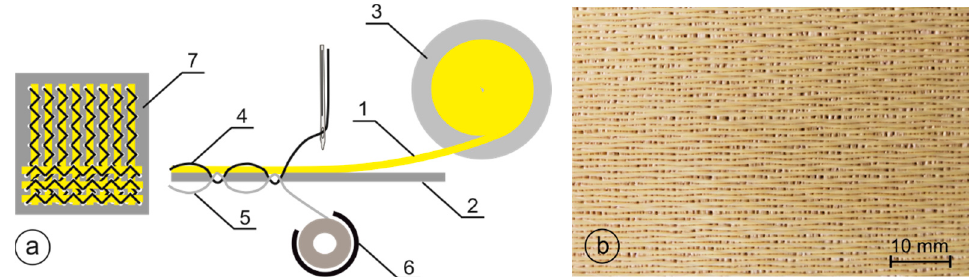
Figure 1. Production of embroidered structures: ( a ) a diagram of the embroidery process (1—para- aramid yarn, 2—PP spun-bonded nonwoven substrate, 3—para-aramid yarn bobbin, 4—main thread zigzagged, 5—thread bottom, 6—swivel hook, and 7—embroidered structure), ( b ) view of the embroidered structure